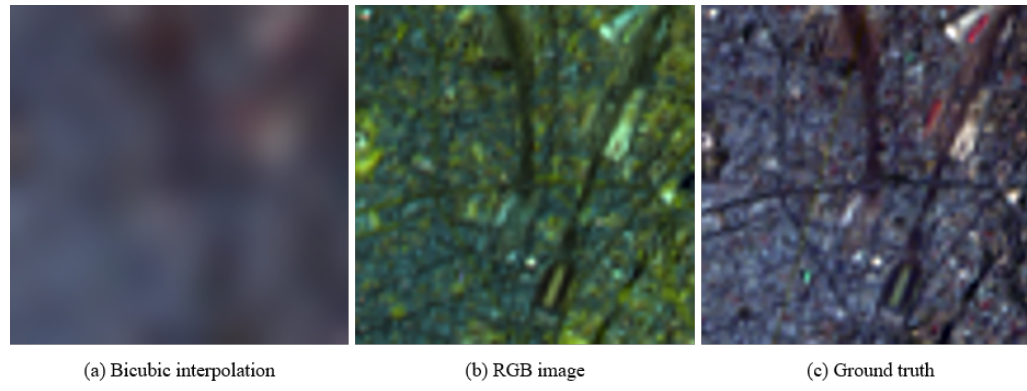
Figure 4. Paris image, where the color image consists of Spectral Bands 28, 13, and 3 for the red, green, and blue channels, respectively. ( a ) Bicubic interpolation of the observed low-spatial-resolution HSI with a magnification factor of three; ( b ) MSI after applying IKONOS spectral response; only red, green, and blue components displayed; ( c ) the original high-spatial-resolution HSI considered as the ground